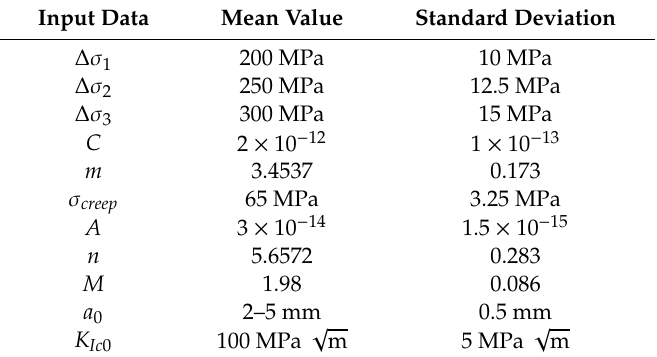
Table 2. Mean values and standard deviation of input data.